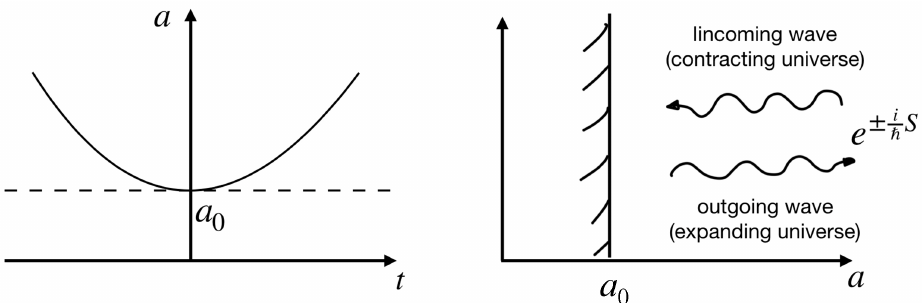
, and ends up in an eternal expansion. 0